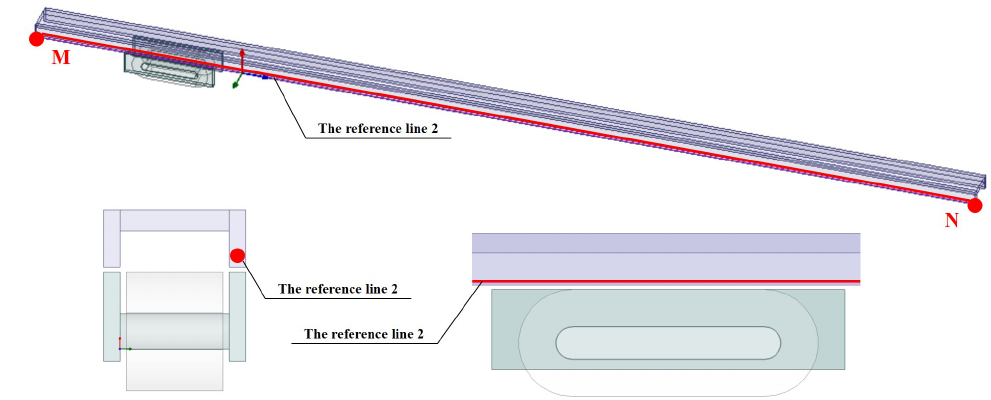
Figure 18. Position of reference line 2.